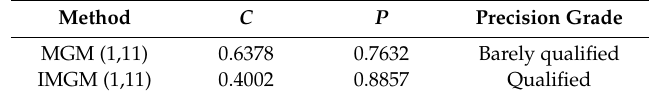
Table 10. The precision grade of MGM (1,11) and IMGM (1,11) for the current